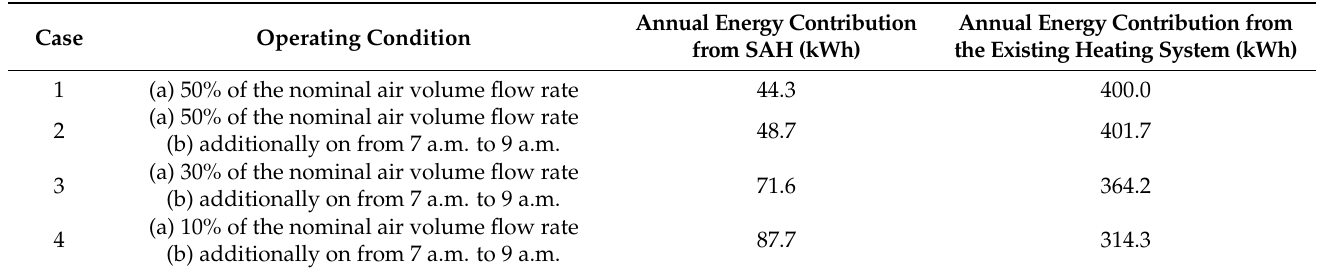
Table 4. Sensitivity analysis on the effect of air volume flow rate and operating hours on SAH energy contribution.